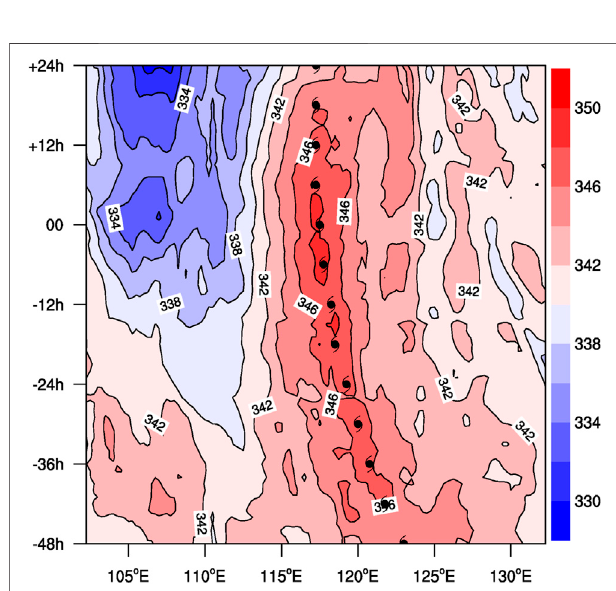
FIGURE 4 | The temporal-longitude variation of EPT at 925-hPa averaged on 15.5 – 17.5 ° N across the TC centers (Contours with shaded are the EPT, Unit: K) (Symbols indicate the longitude position of typhoon